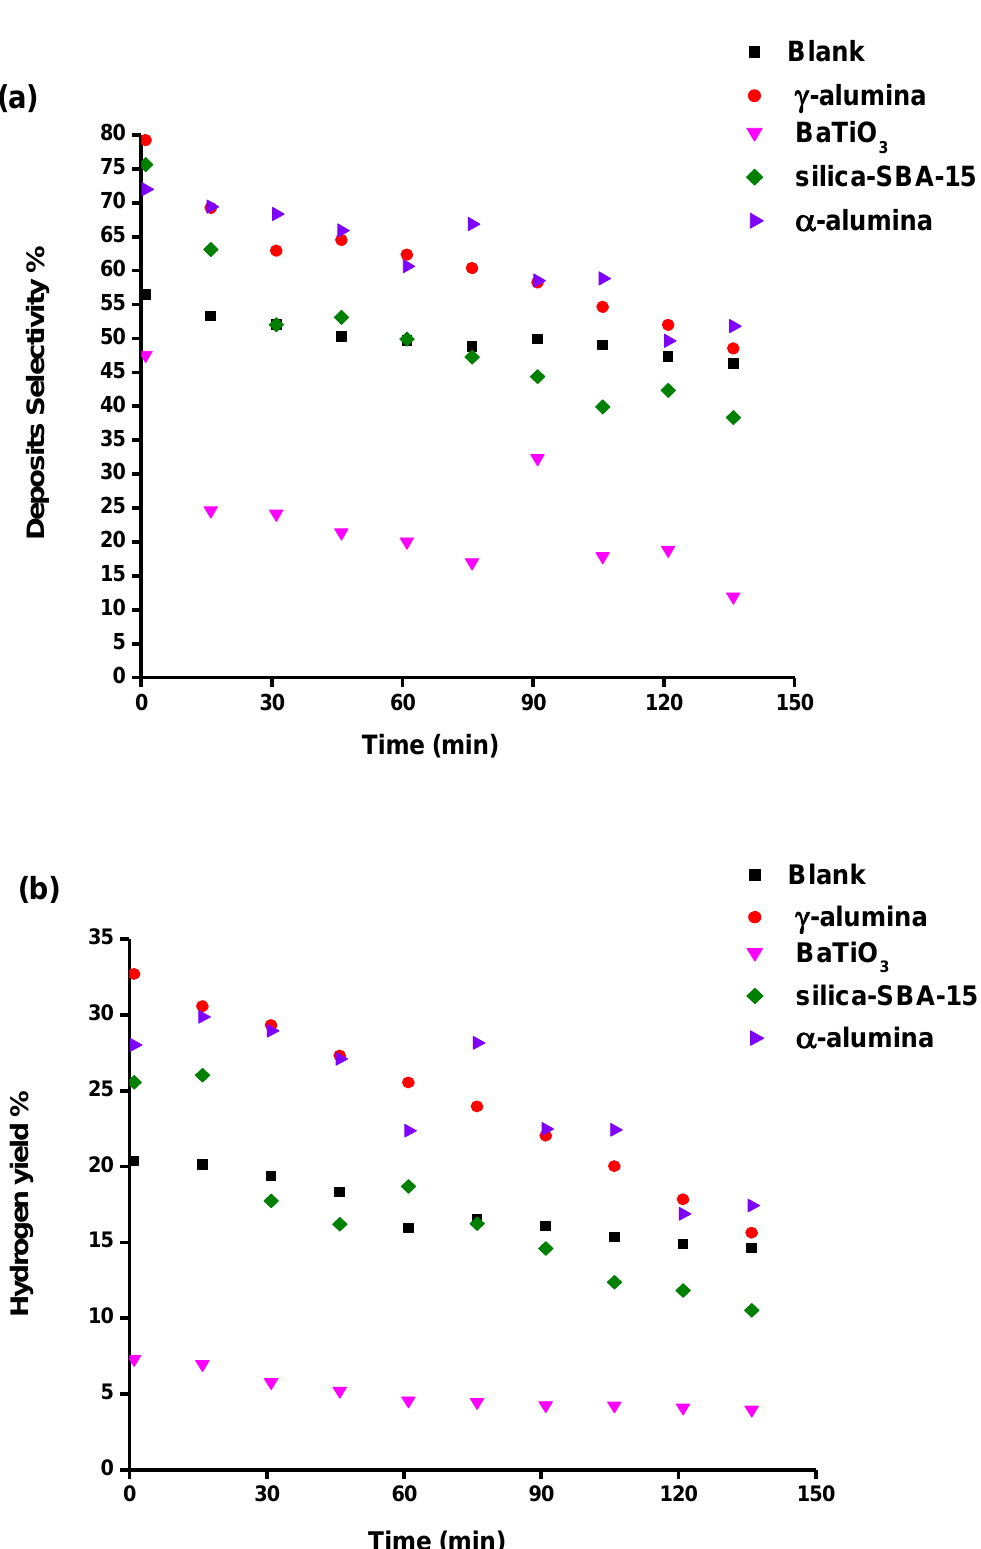
Figure 9. The selectivity of deposits ( a ) and the yield of H 2 ( b ) as a function of time for different packing materials.